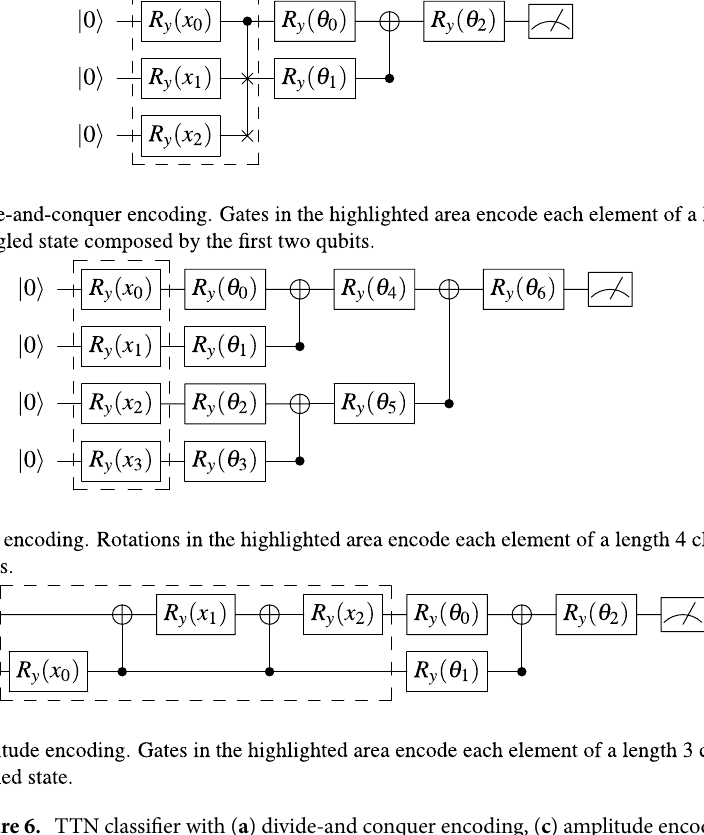
Figure 6. TTN classifier with ( a ) divide-and conquer encoding, ( c ) amplitude encoding and ( b ) qubit